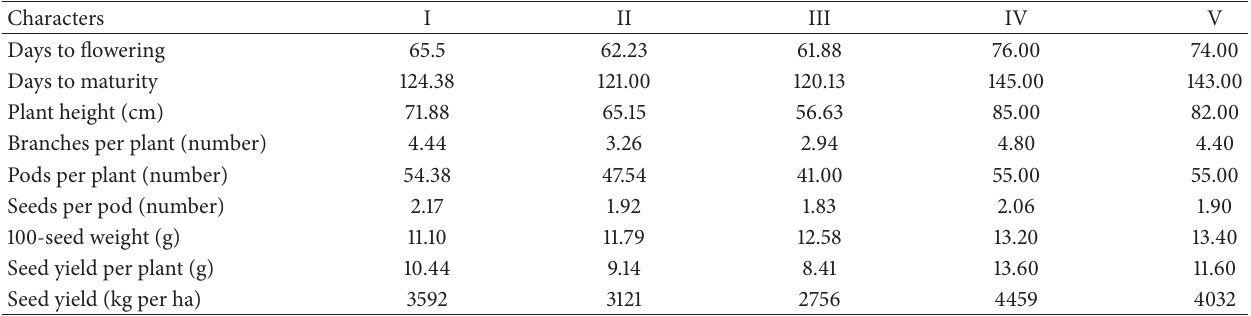
Figure 1: Dendrogram showing relationship among 31 soybean genotypes using nine phenological and morphological characters, seed yield, and yield traits. Table 9: Mean values of nine different phenological and morphological characters, yield attributes, and seed yield for five groups revealed by cluster analysis among 31 soybean